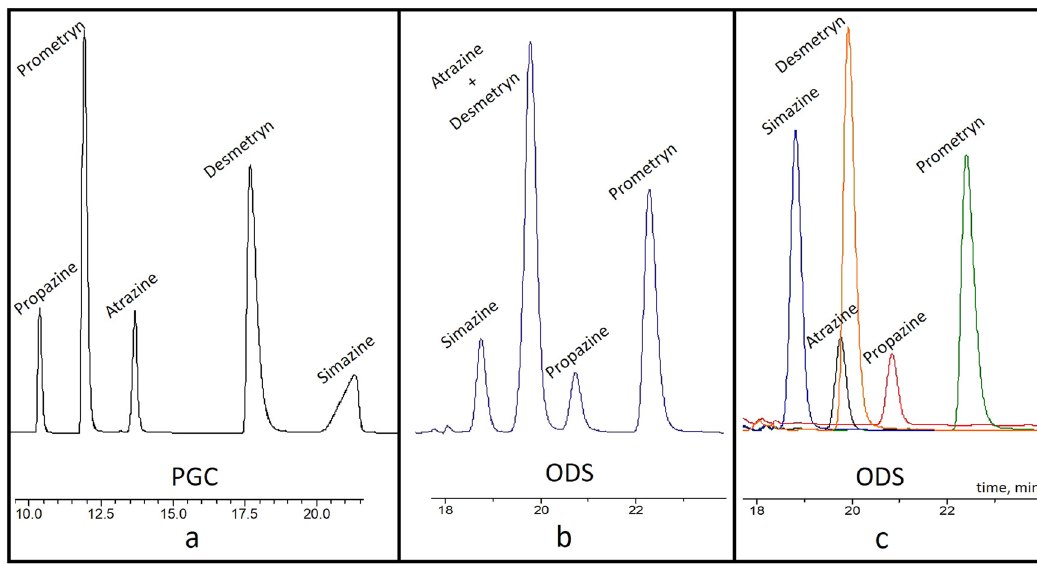
Figure 2: Chromatograms of triazine herbicides mixture solution on PGC ( a ) and on ODS ( b ) columns; overlapped chromatogram of individual herbicides solutions on ODS column ( c )